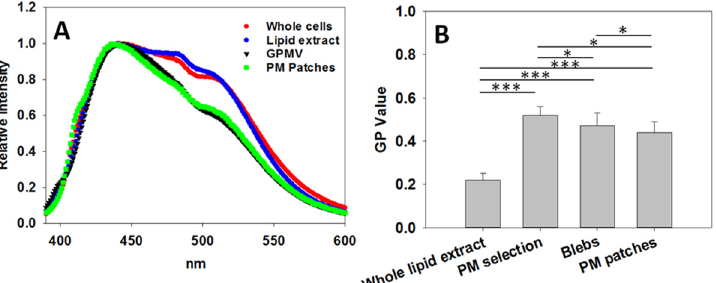
Figure 4. Laurdan GP measurements. ( A ), Laurdan fluorescence emission spectra. Red, whole CHO cells; blue, SUV formed from CHO cell lipid extract; black, GPMV (blebs) from CHO cells; green, PM patches from CHO cells. Spectra retrieved at 40 °C. ( B ), Laurdan GP values obtained from microscopy images such as shown in Figure 1, 2A, 2C, 3A, (at 20 °C, n = 150, value = mean + SD). Statistically significant differences were calculated with ANOVA and Student’s t-test. Significance: (*) p < 0.05; (***) p < 0.001.